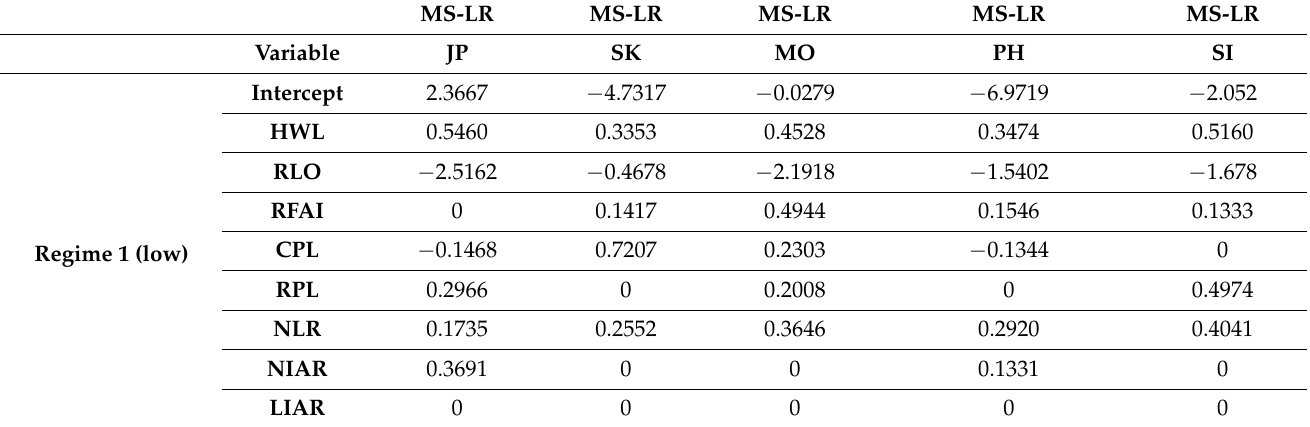
Table 4. The results of MS regression model for 10 originating